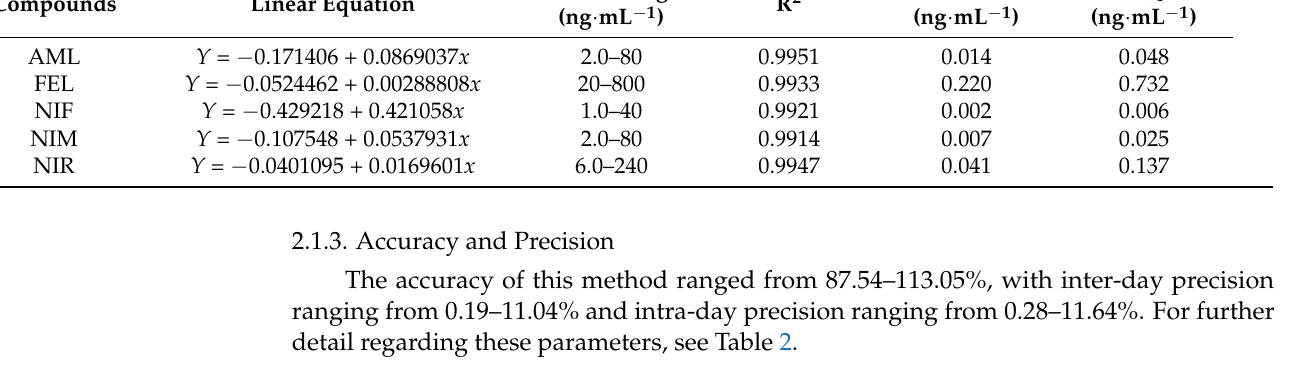
Table 2. ME, extraction recovery, accuracy, and precision of five compounds ( n =